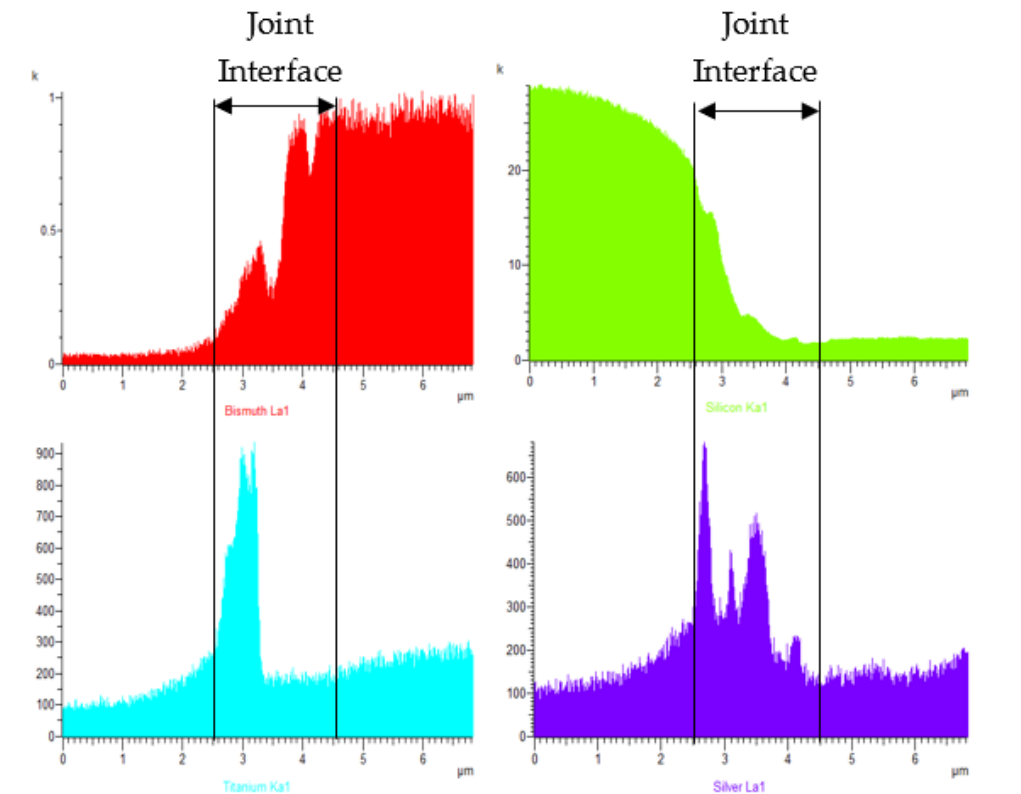
Figure 16. Line EDX analysis of Si/Bi11Ag1.5Ti joint and the concentration profiles of Bi, Si, Ti, and Ag elements.